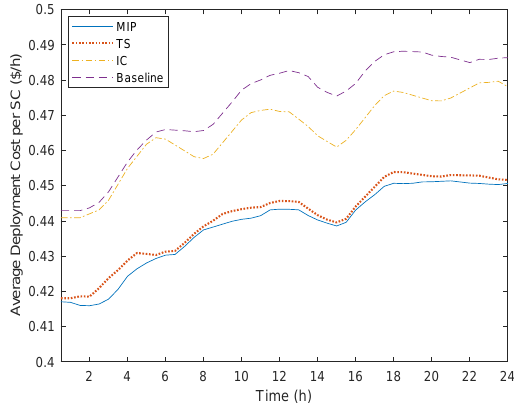
Figure 9. Average deployment cost per service